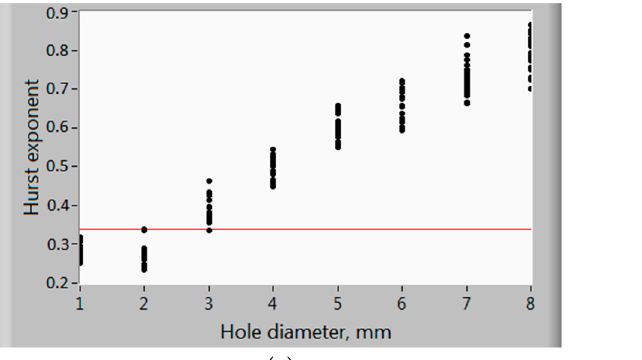
Figure 6. Values of the Hurst exponent at a pump discharge pressure of 1.5 bar: ( a ) for X-axis sig- nals, ( b ) for Y-axis signals.